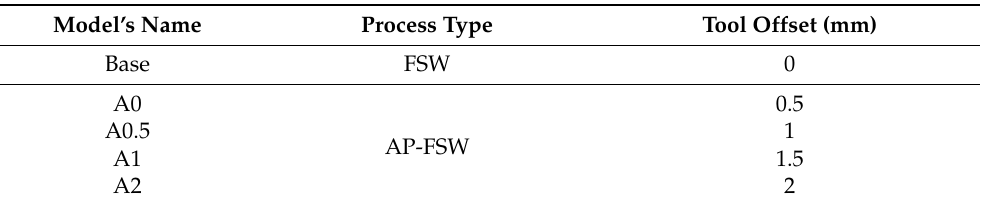
Table 3. Experimental